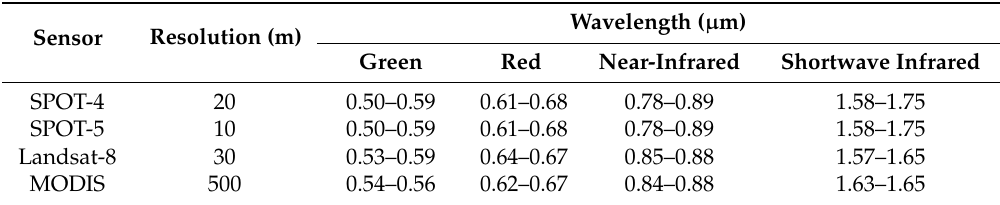
Table 1. Wavelength characteristics of the spectral bands used to identify snow cover for images acquired by the four sensors employed in this study.